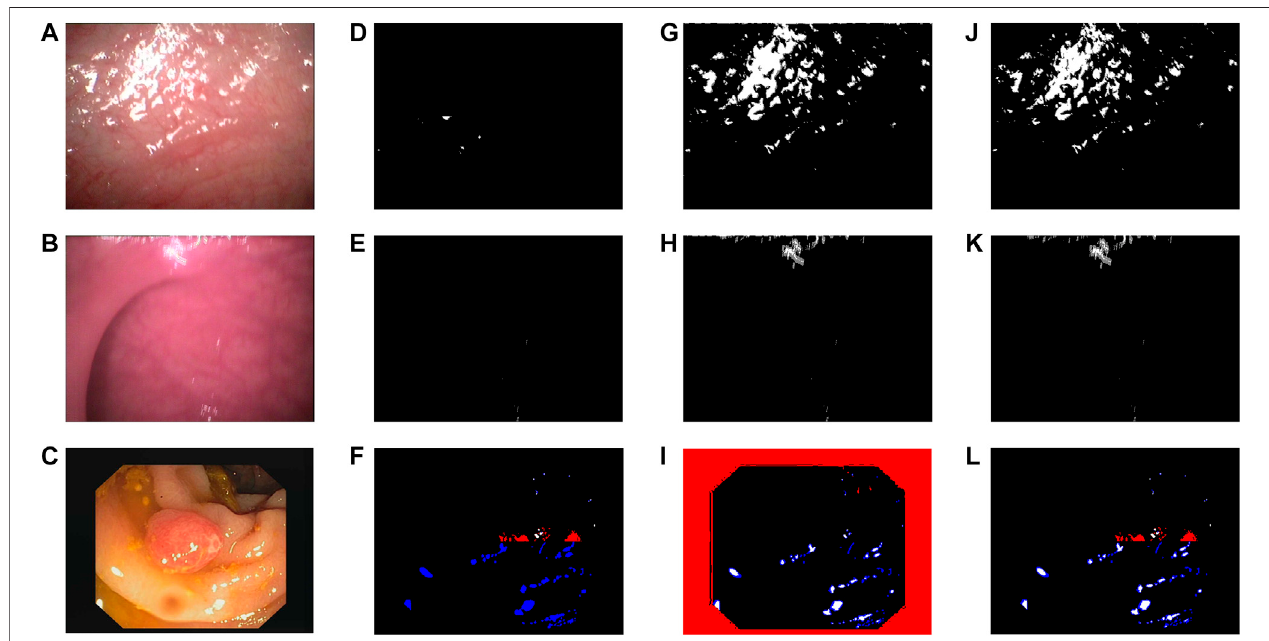
FIGURE 2 | Performance of the proposed highlight detection method. (A) – (B) Original images from clinical data. (C) Original image from CVC-ClinicSpec. (D) – (F) Applying (1). (G) – (I) Applying (1) and (5). (J) – (L) Proposed method.